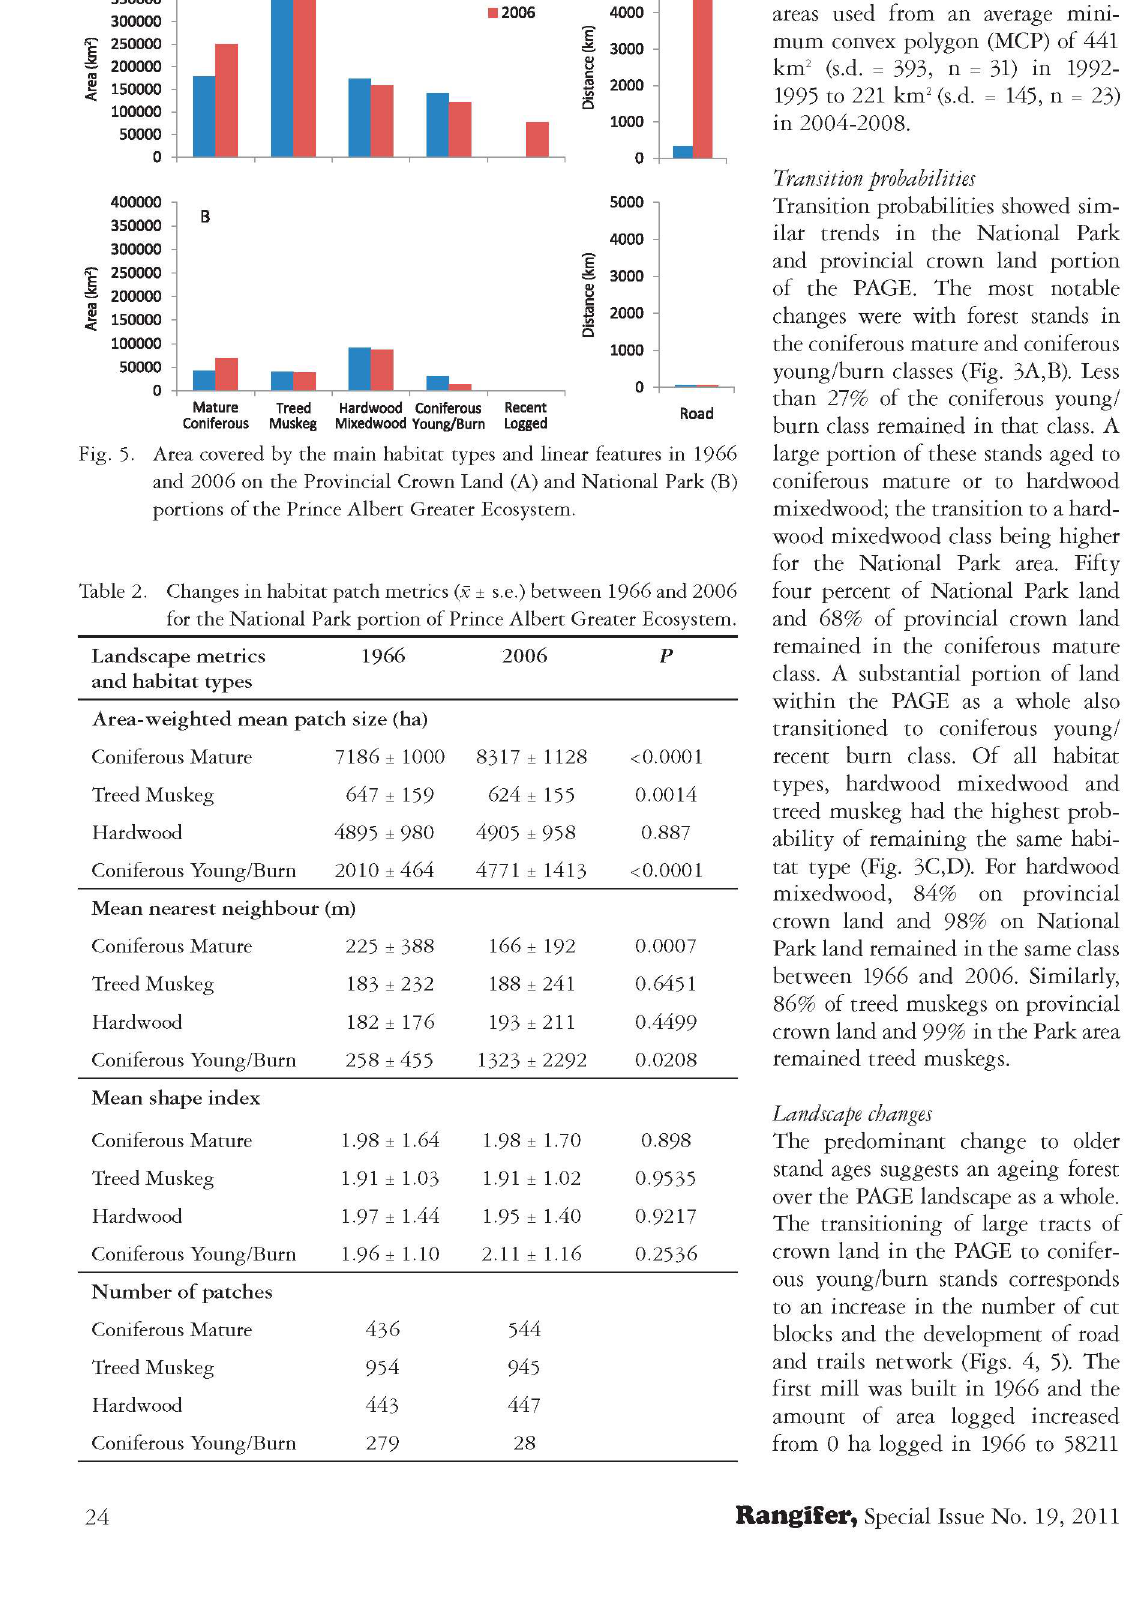
Fig. 5. Area covered by the main habitat types and linear features in 1966 and 2006 on the Provincial Crown Land (A) and National Park (B) portions of the Prince Albert Greater Ecosystem.